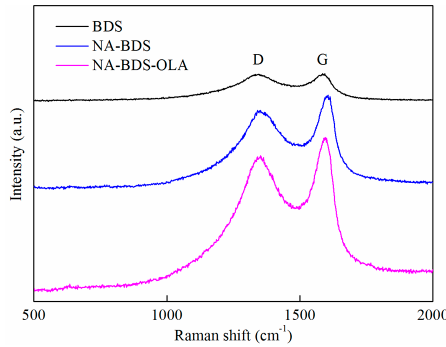
Figure 2. Raman spectra of biodiesel soot (BDS), nitric-acid-treated BDS (NA-BDS), and NA-BDS modified with oleylamine (NA-BDS-OLA).